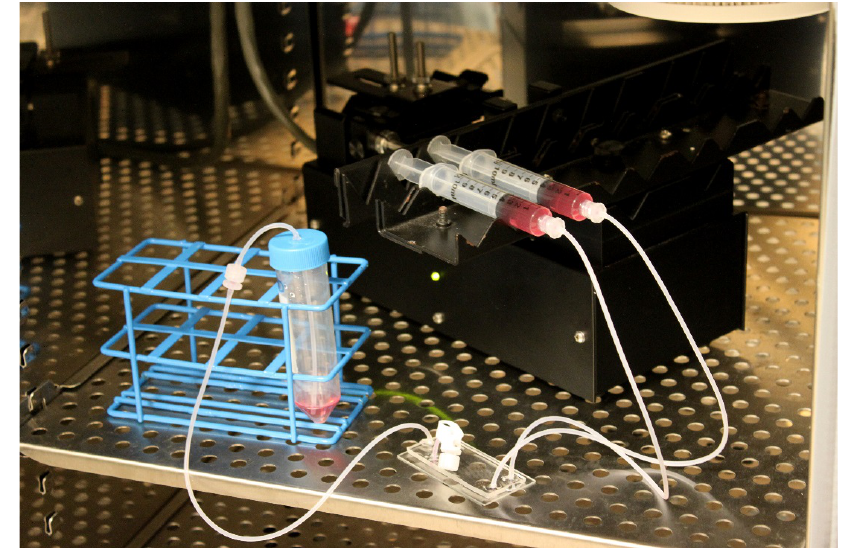
Figure 2. Gradient generating device MSC culture